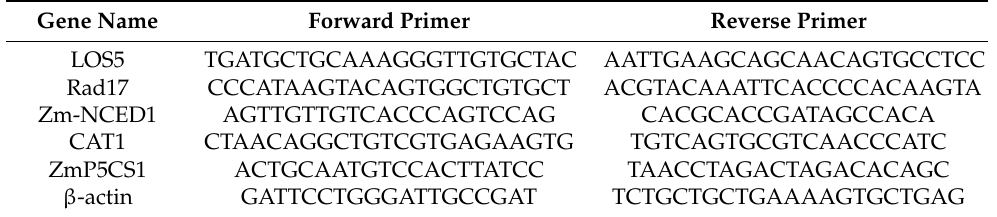
Table 1. Sequences of primers used in RT-PCR (5 (cid:48) –3 (cid:48)